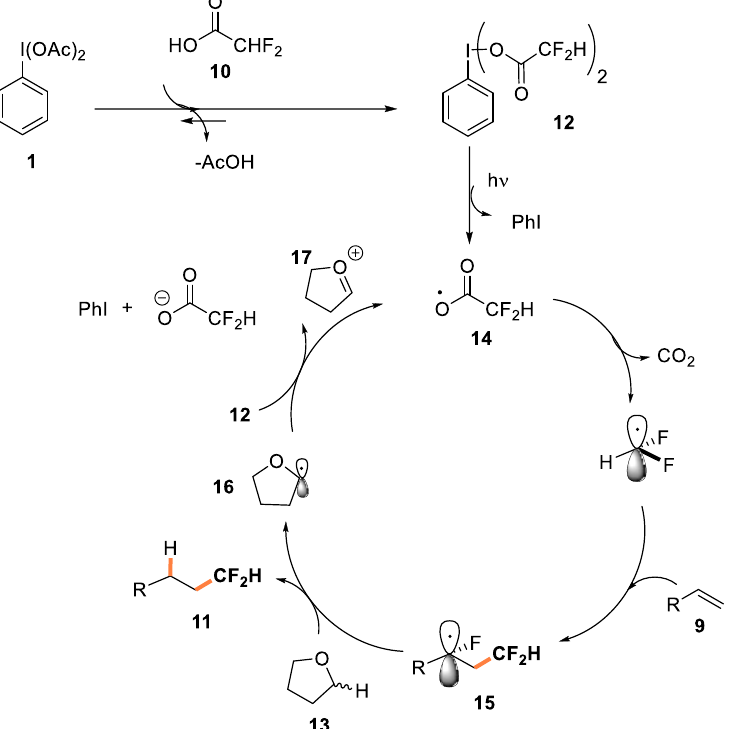
Figure 3. PhI(OAc) 2 -mediated radical pathway for the hydrodifluoromethylation of terminal